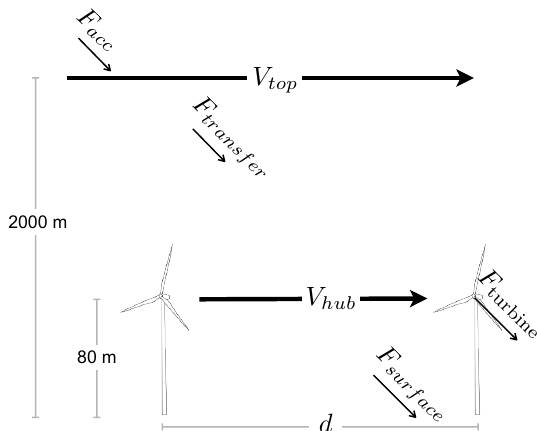
Fig. 1. Schematic illustration of the vertical fluxes of horizontal mo- mentum in the atmospheric boundary layer. Momentum is imported from the upper atmosphere at the rate F acc and diffuses to lower layers at the rate F transfer , which is driven by the velocity gradient. Wind turbines extract some of this momentum at v hub to generate electrical energy ( F turbine ).